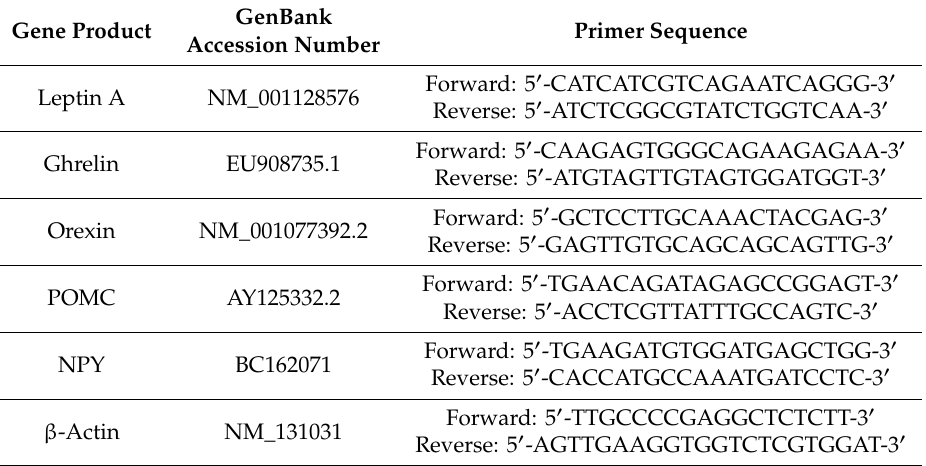
Table 1. Oligonucleotide primers used for real-time